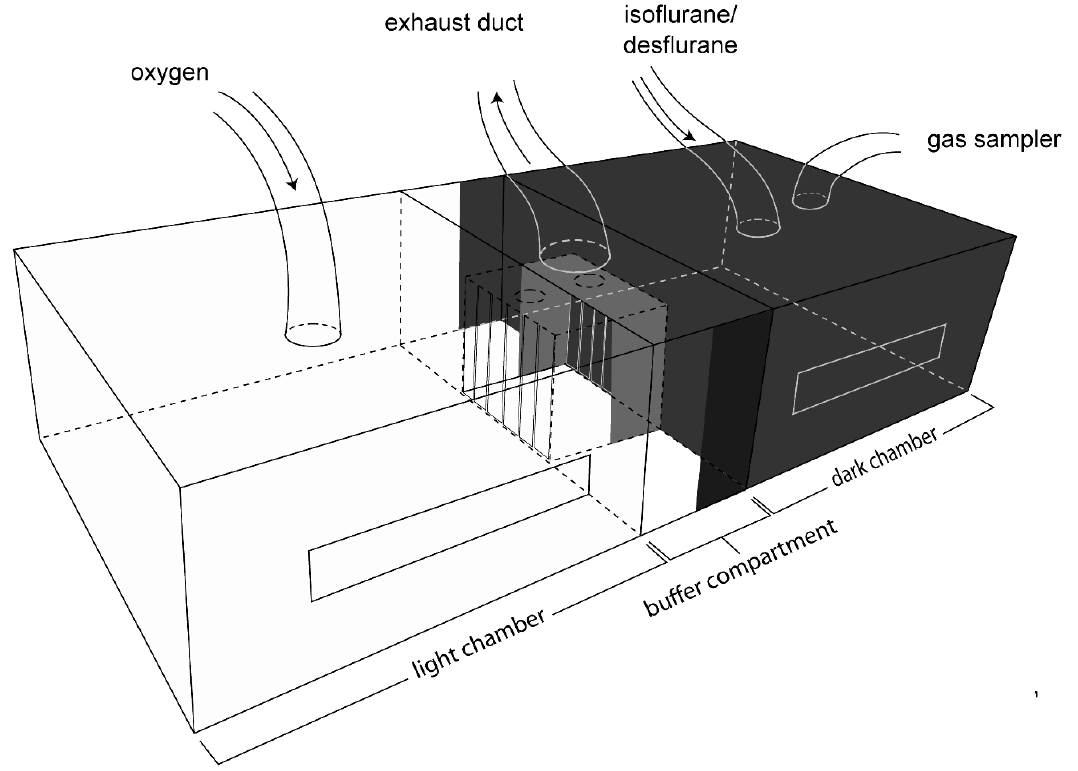
Figure 1. Illustration of the aversion-avoidance testing apparatus.